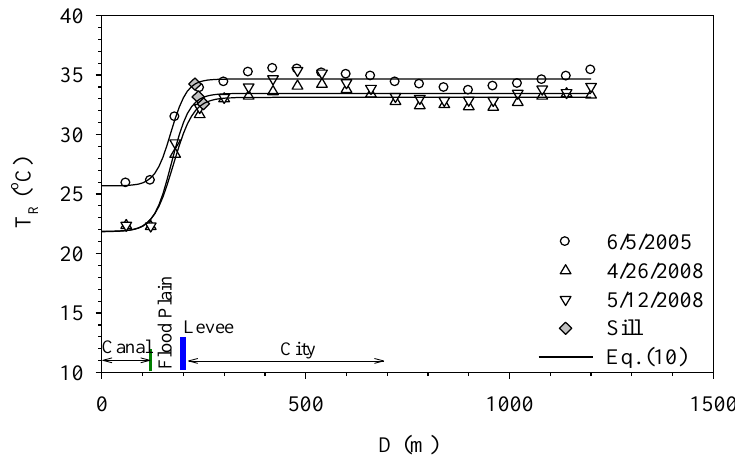
Figure 10. Surface temperature variation at Breeze Canal Location.